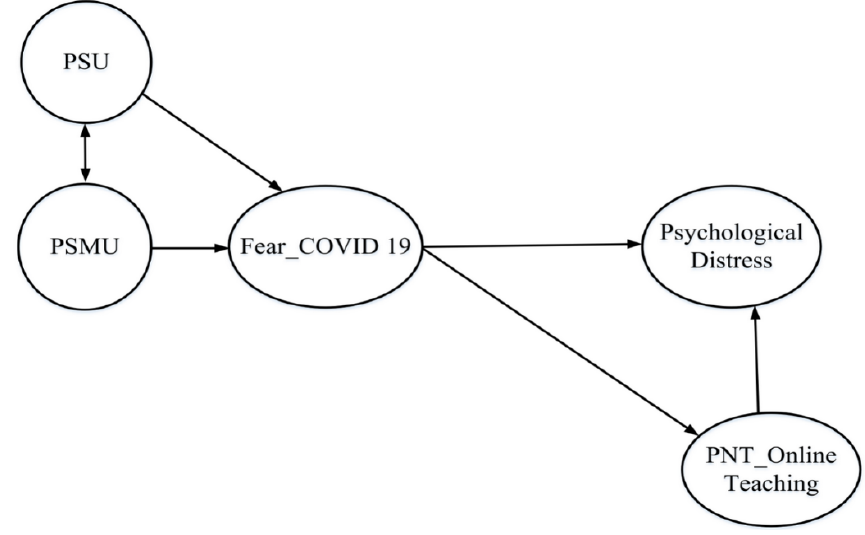
Figure 1. Conceptual Model.